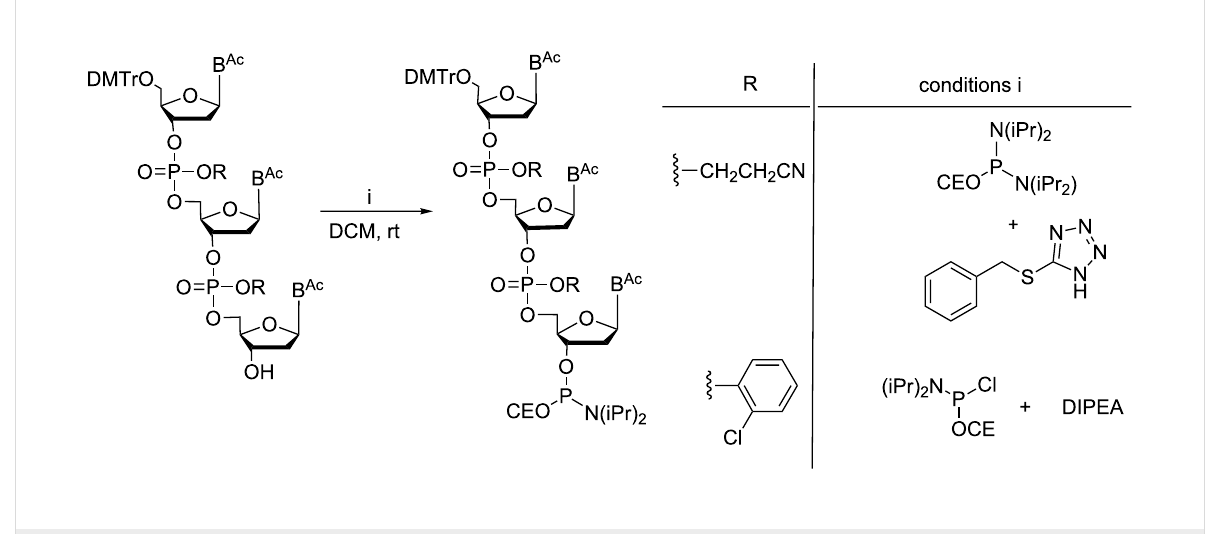
Figure 7: Phosphitylation of trimers. Reaction conditions, in particular the choice of the phosphitylation reagent, are dependent on the nature of the protecting group at the internucleotide